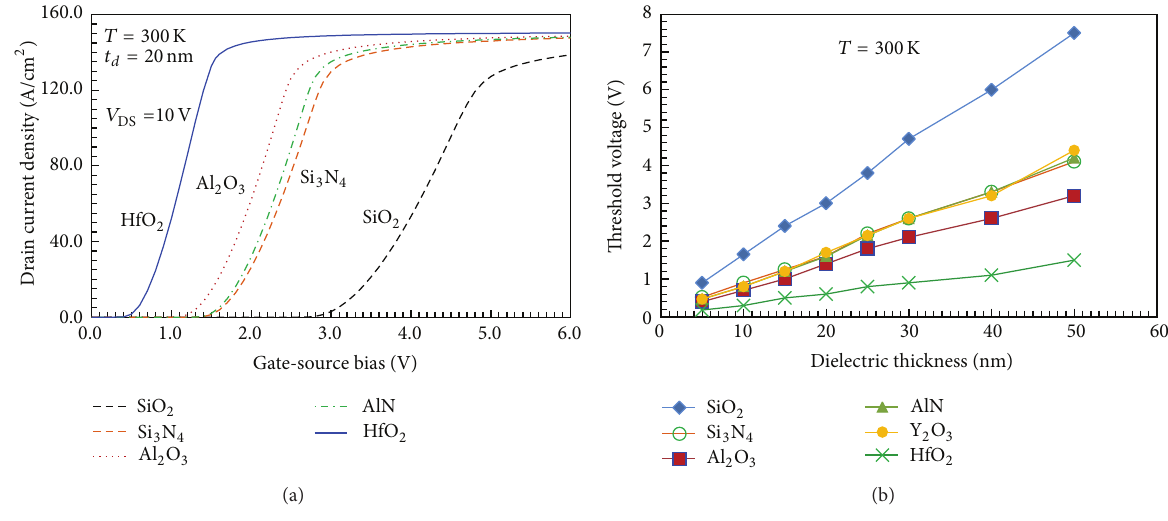
Figure 6: Drain current density as a function of gate-source bias for various gate dielectrics using 20 nm thick dielectric material (a) and threshold voltage shift as a function of dielectric thickness for various gate dielectrics (b). Threshold voltages of Si 3 N 4 , Y 2 O 3 , and AlN are clustered with each other as a result of smaller difference in the bandgap of these materials. Simulations have been performed for 20 nm thick gate dielectric at 300